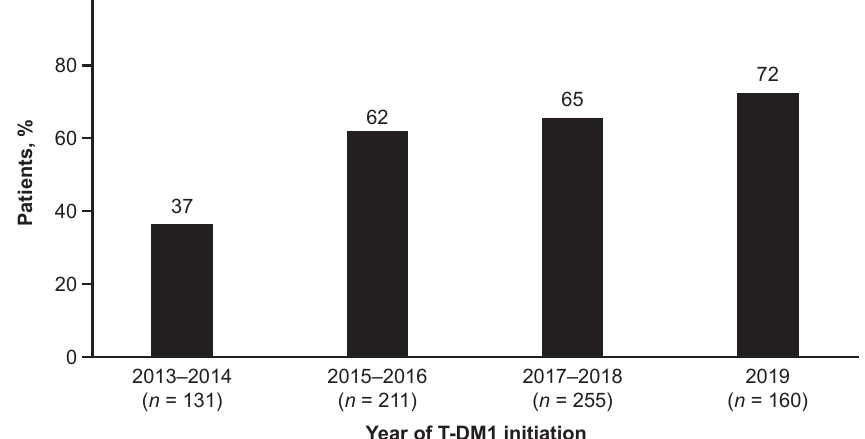
Figure 1. Proportion of patients in the primary cohort who initiated T-DM1 following treatment with pertuzumab by calendar year. The primary cohort comprised patients who received T-DM1 in any treatment line. T-DM1 = trastuzumab